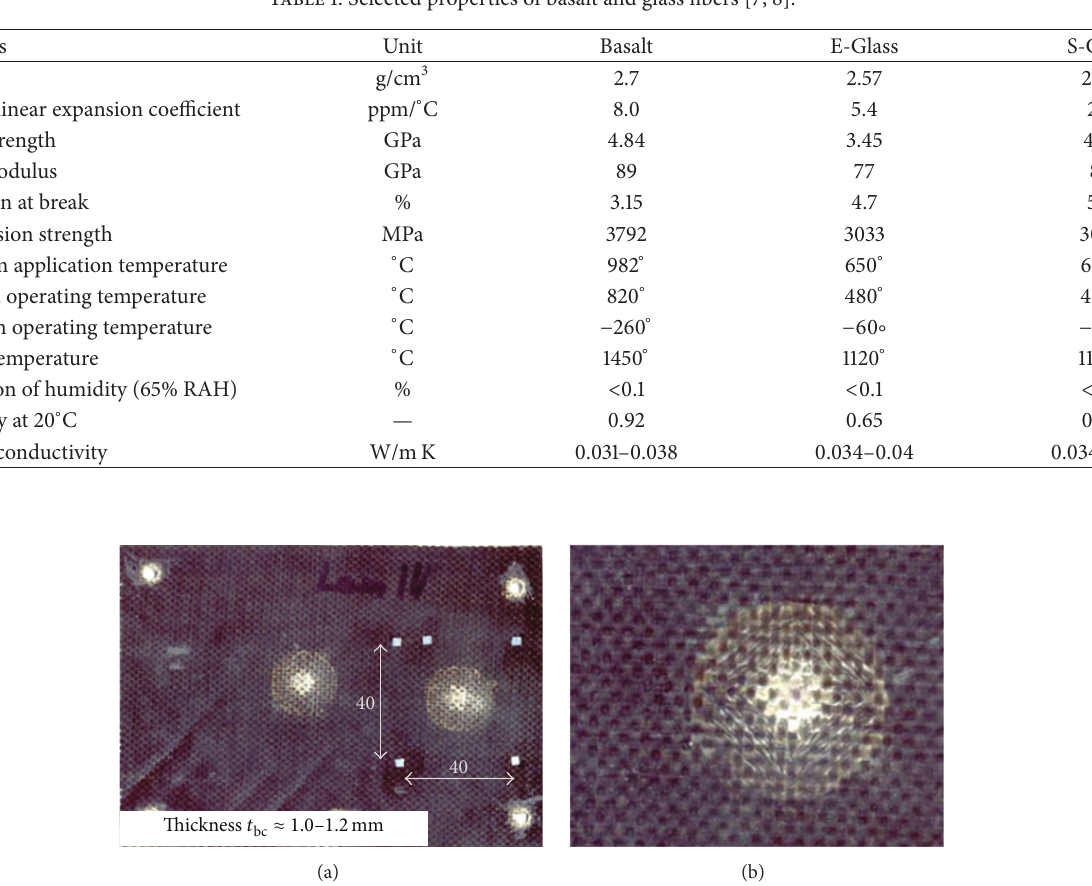
Figure 1: Photo of the examined specimen 𝑠 IMC 5 J (basalt reinforced composite material exposed to impact energy): (a) general view and (b) enlargement of measured